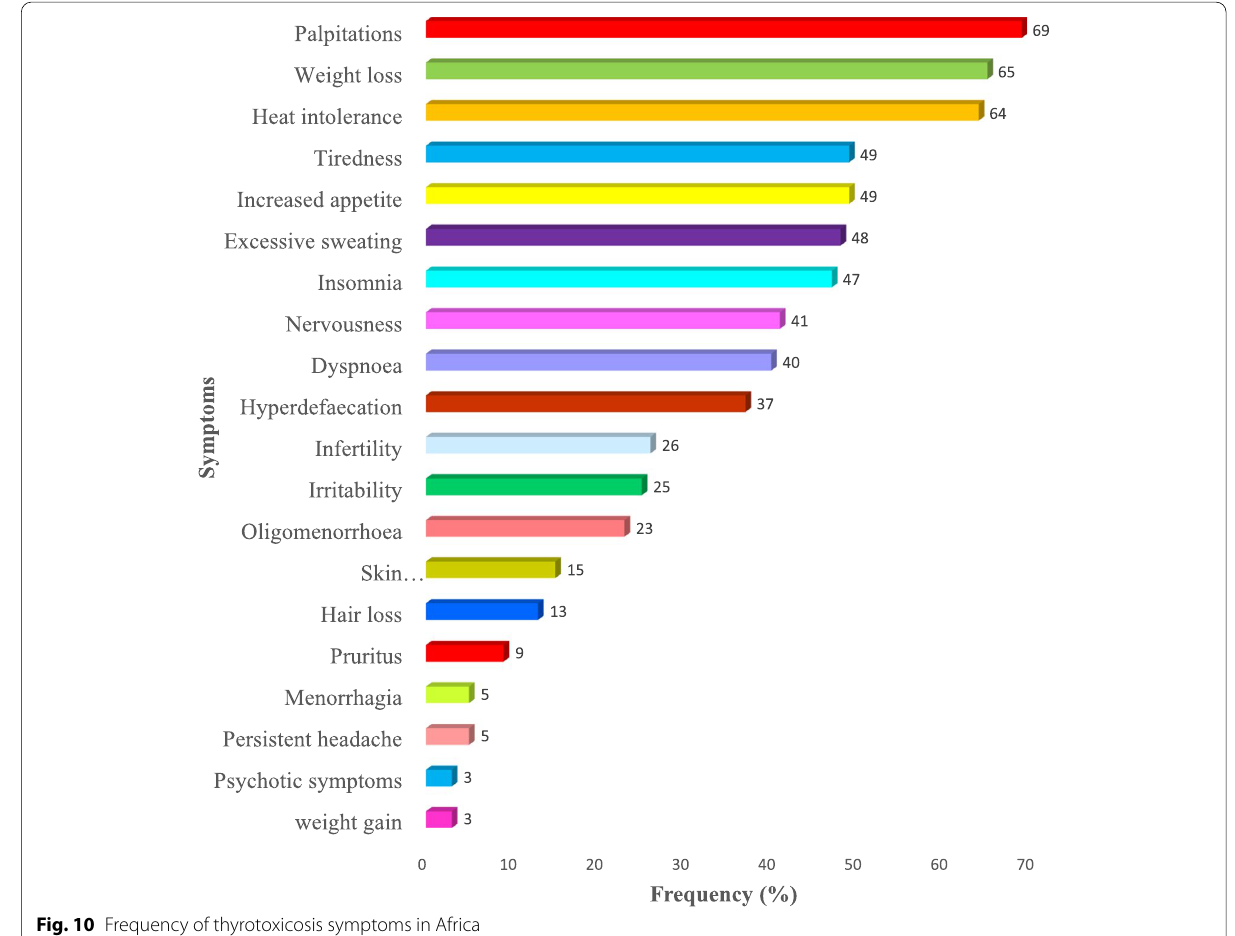
Fig. 10 Frequency of thyrotoxicosis symptoms in